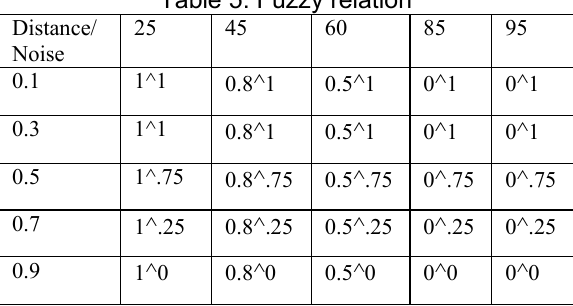
Table 5. Fuzzy relation